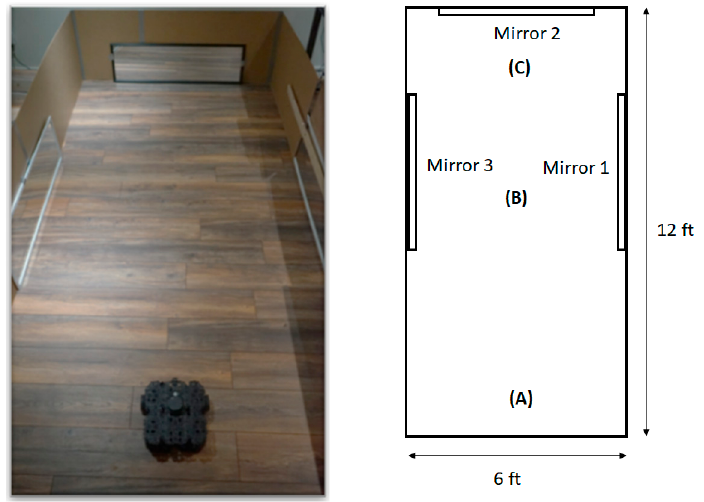
Figure 6. Constructed experimental setup and representation of the various mirror position condition setups with mobile robot locations A, B and C.